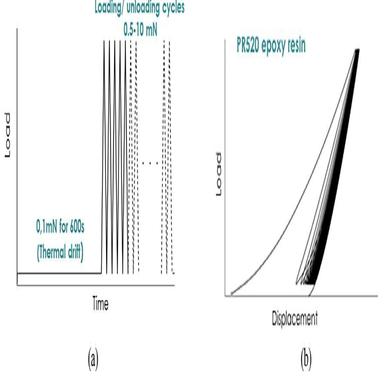
Cyclic indentation test protocol used in this study to evaluate time dependent indentation response of polymer and polymer matrix composite (a) and typical result of cyclic indentation test on PR520 epoxy resin (b).